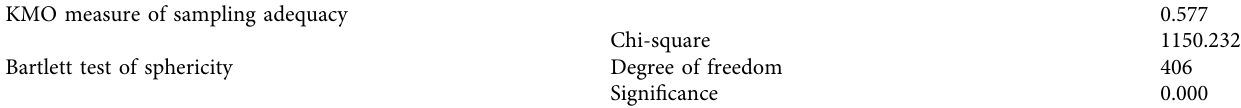
Table 3: Results of the KMO and SMC test.